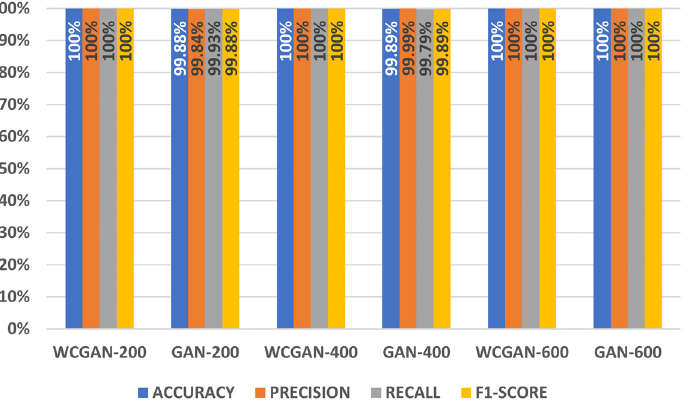
Figure 12. Histograms of the performance of our new GB-based classifiers on our new generated training sets.